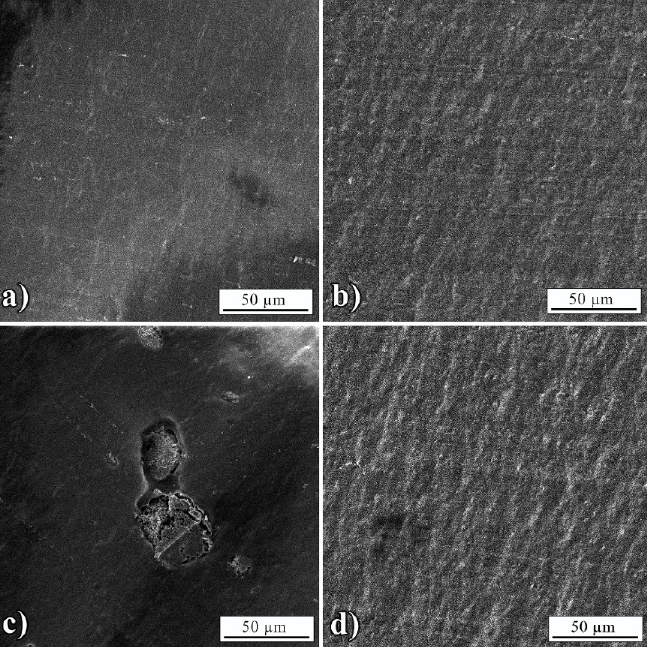
Figure 6. FE-SEM micrographs of: ( a ) Peeled BT interface with L8079, ( b ) L8079 interface after removing BT, ( c ) peeled BT+5 wt.% Mn-Al LDH interface, and ( d ) L8079 interface after removing BT+5 wt.% Mn-Al LDH.